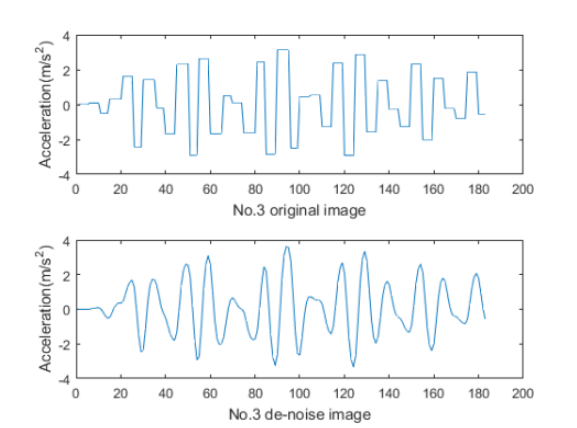
Figure 4. Gait analysis of No. 3 experimenter